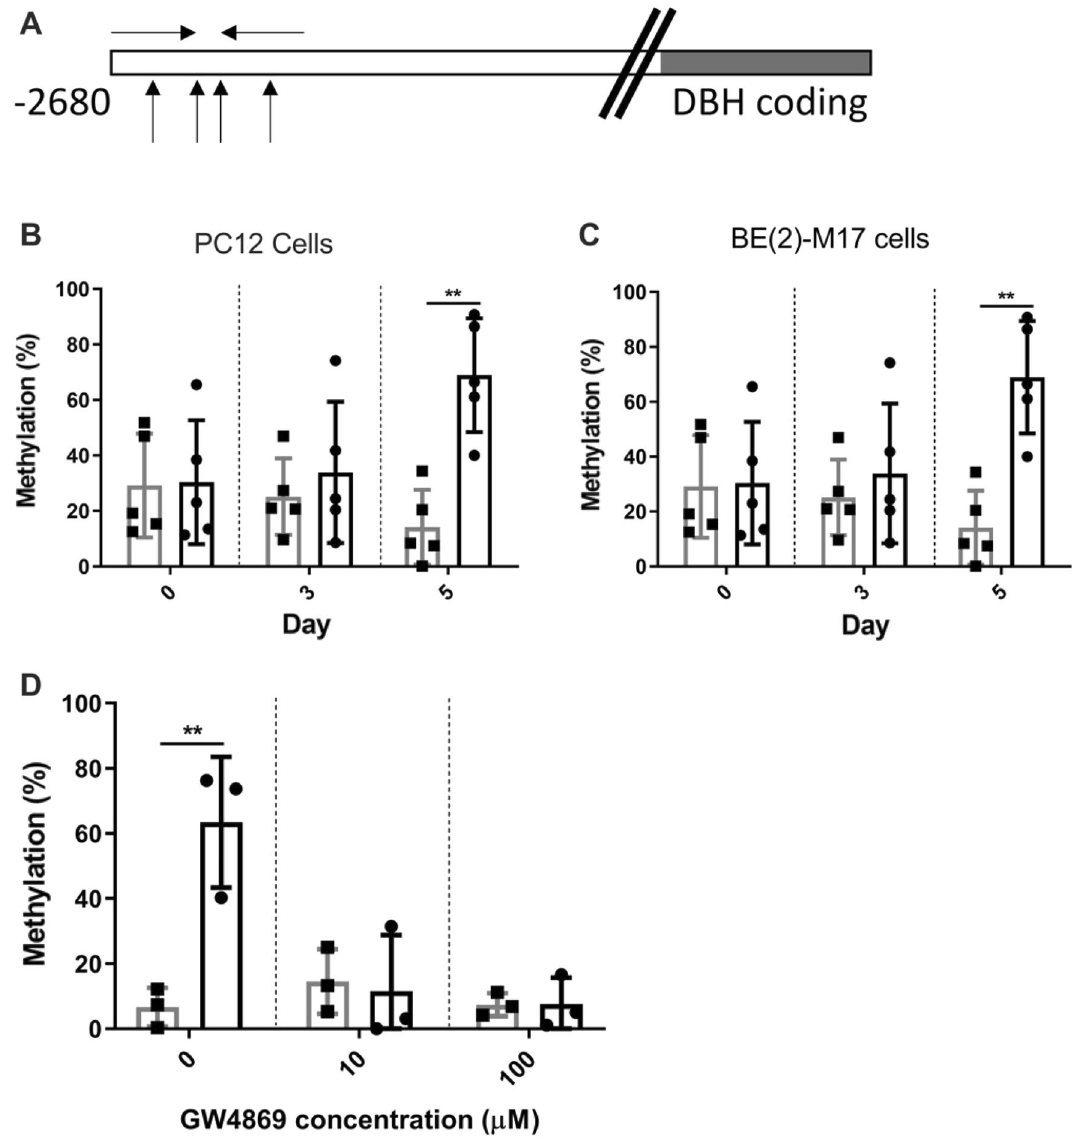
Figure 3. The promoter region of the DBH gene is hypermethylated during T. gondii infection. (A) Diagram depicting the DBH promoter analysis by Methylation Sensitive Restriction Enzyme qPCR (MSRE-qPCR). The DBH coding region is shaded grey. The location of the methylation sensitive restriction enzyme sites are shown with up arrows and the primer sites with facing arrows (not to scale). (B) DBH promoter methylation was measured as a percentage of methylation in the 5’ region in PC12 cells as measured by MSRE-qPCR. DNA was collected at 0, 3 and 5 days post-infection from uninfected (grey) or infected (black) cultures. MOI = 1; n = 5, *** p = 0.0007. (C) Methylation measured as in ( B ) during course of infection for human neuronal (BE(2)-M17) cells. MOI = 1; n = 5, ** p = 0.0011. Unpaired Student’s t tests, ± SEM shown. (D) Treatment with GW4869, a neutral sphingomyelinase (N-SMase) inhibitor, disrupted the DBH promoter methylation by permeable factors in the transwell system. DBH promoter methylation in the lower layer exposed cells was quantified by MSRE qPCR as described above. ± SEM shown, n = 3, Student’s t test, ** p =